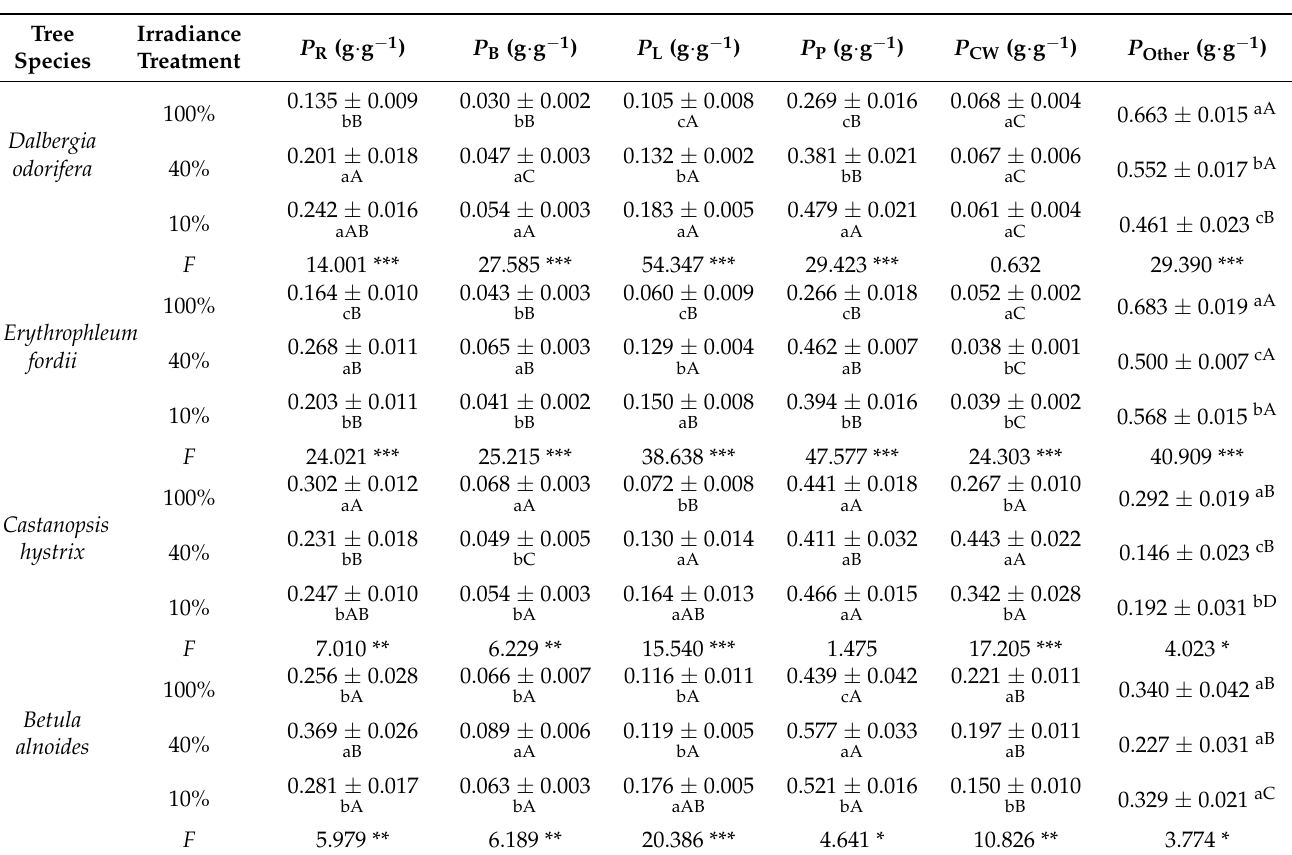
Table 4. Nitrogen allocation proportion of Rubisco ( P R ), bioenergetics ( P B ), light-harvesting components ( P L ), photosynthetic system ( P P ), cell wall ( P CW ) and other parts ( P Other ) in Dalbergia odorifera , Erythrophleum fordii, Betula alnoides , and Castanopsis hystrix grown under three different irradiance treatments. Data are means of seven plants per treatment ± SE. Lower case letters indicate significant difference at 0.05 levels among the irradiance treatments, whereas capital letters indicate significant difference at 0.05 levels among species under same irradiance treatment. F -ratios with statistically significant values denoted by * p < 0.05, ** p < 0.01, *** p < 0.001 among irradiance